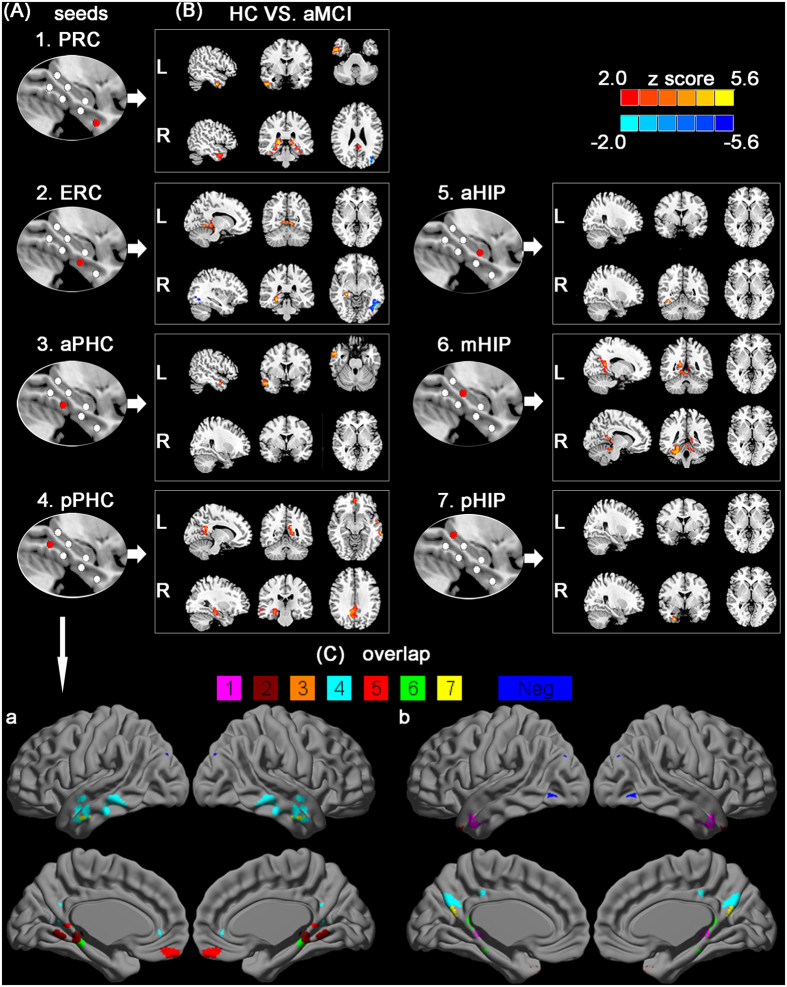
Resting-state functional connectivity patterns between group maps of the distinct MTL subregions.(A) First column shows the subregions defined in MTL. (B) Last column shows the between-group statistical maps, with statistical threshold set at pcorrected < 0.01, corrected by AlphaSim. Warm and blue colors indicate decreased and increased functional connectivity in aMCI subjects compared to healthy controls. Color bar is presented with z score, respectively. (C) The spatial overlap in left (a) and right (b) parahippocampal and hippocampal seeds shows all brain regions of disrupted functional connectivity in aMCI subjects compared to healthy controls. The color bar (1–7 colors) indicates disrupted connectivity maps derived from each seed. Blue color shows these regions of increased functional connectivity in aMCI subjects compared to healthy controls. Notes: aHIP, anterior hippocampus; mHIP, middle hippocampus; pHIP, posterior hippocampus; PRC, perirhinal cortex; ERC, entorhinal cortex; aPHC, anterior parahippocampal cortex; pPHC, posterior parahippocampal cortex; L, the left MTL subregional networks; R, the right MTL subregional networks.